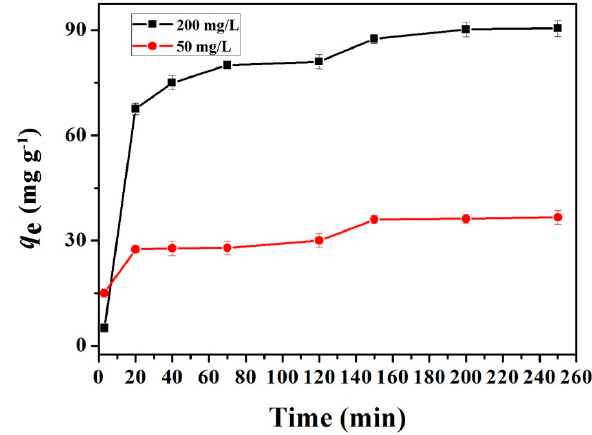
Figure 9. Adsorption of Cu 2+ on the GO(20)/cellulose(100) hydrogel as a function of contact time. The error bars represent standard deviations based on three measurements.